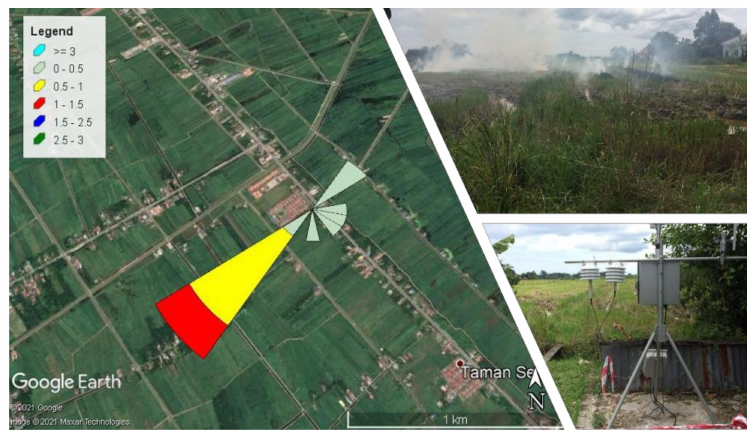
Figure 5. Wind rose plot, blowing from 12 h at Site